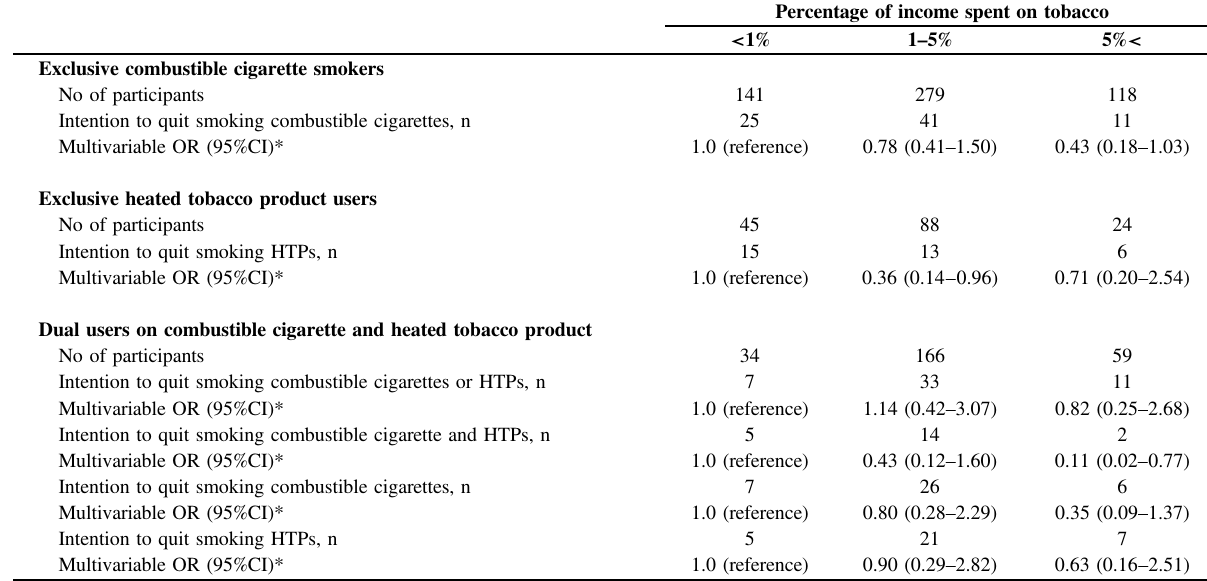
Table 3 Intention to quit smoking according to percentage of income spent on tobacco